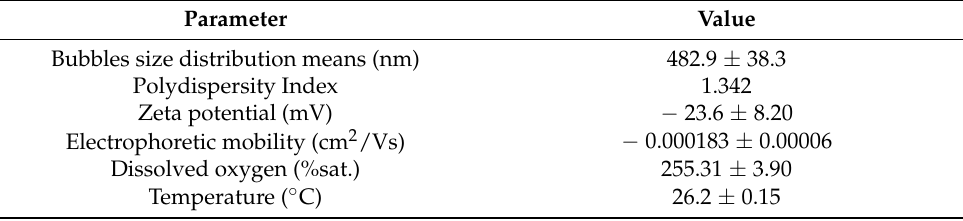
Table 1. The bubbles characteristic and water quality profile in the ultrafine bubbles tank.